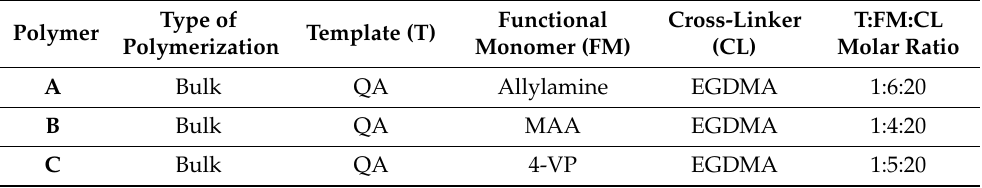
Table 1. Chemical composition of prepared